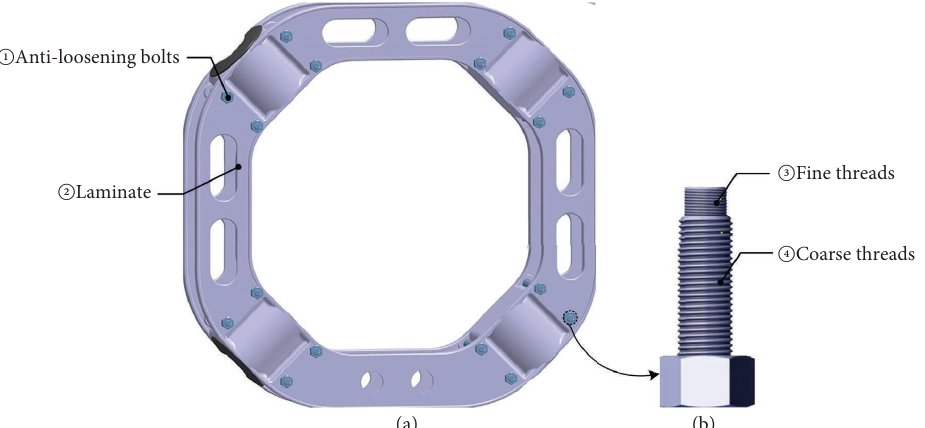
Figure 9: Frame plate structure of the new quad-bundle spacer damper: (a) frame plate component composition and (b) antiloosening bolt structure.